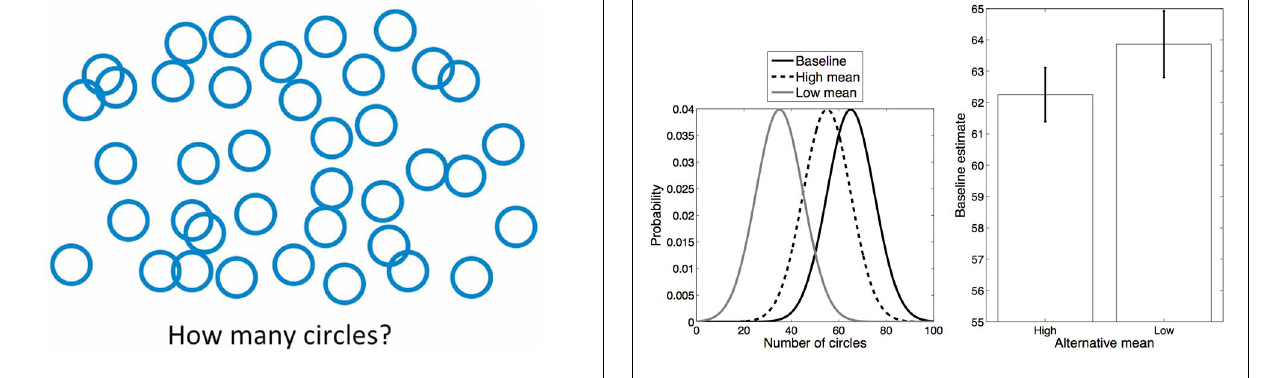
FIGURE 1 | Example trial. On each trial, participants were presented with a random scattering of circles and asked to estimate the number of circles. The circles on each trial were all of the same color, and the number of circles was drawn from a color-specific Gaussian distribution.